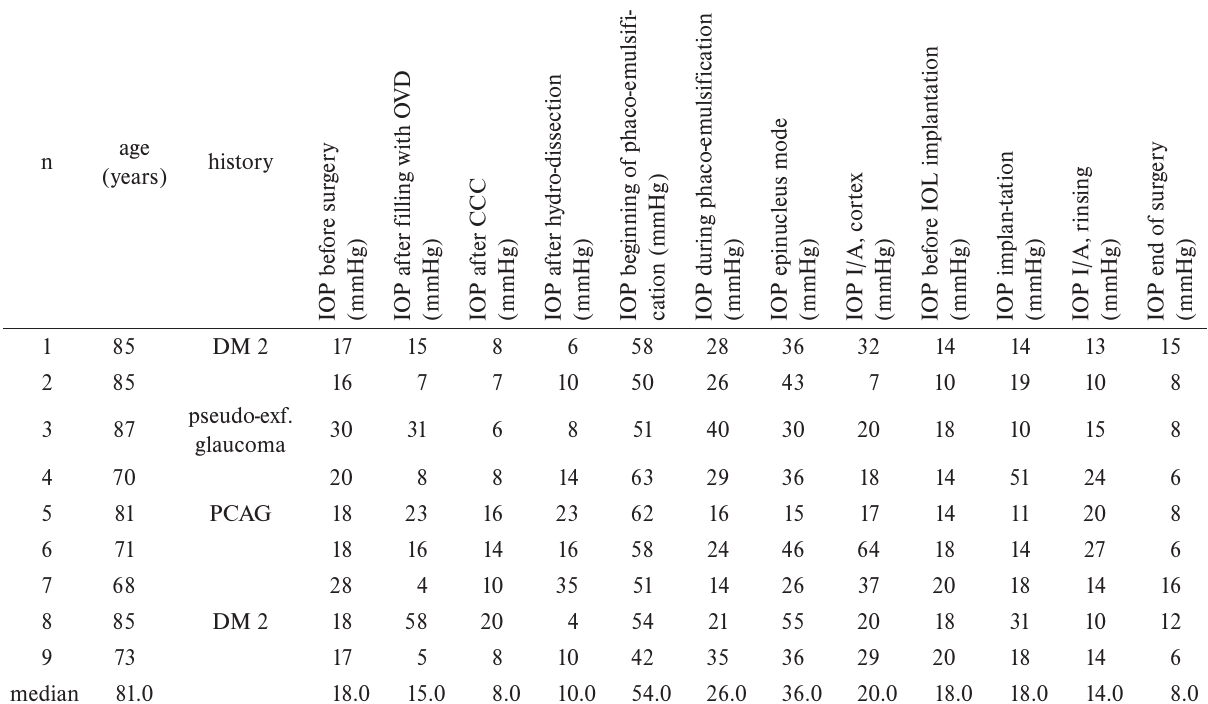
Table 1. IOP measured in all ususal steps of phacoemulsification.